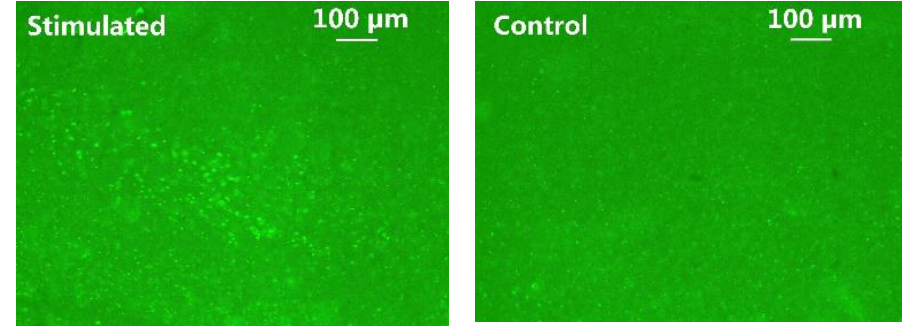
Figure 14. C-Fos expression in the left (stimulated) vs. right (control) V1 lobes.